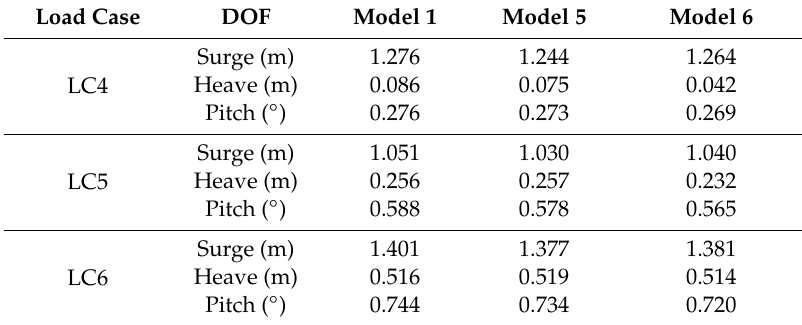
Table 16. Motion standard deviation of the inclined upper column models under irregular waves.